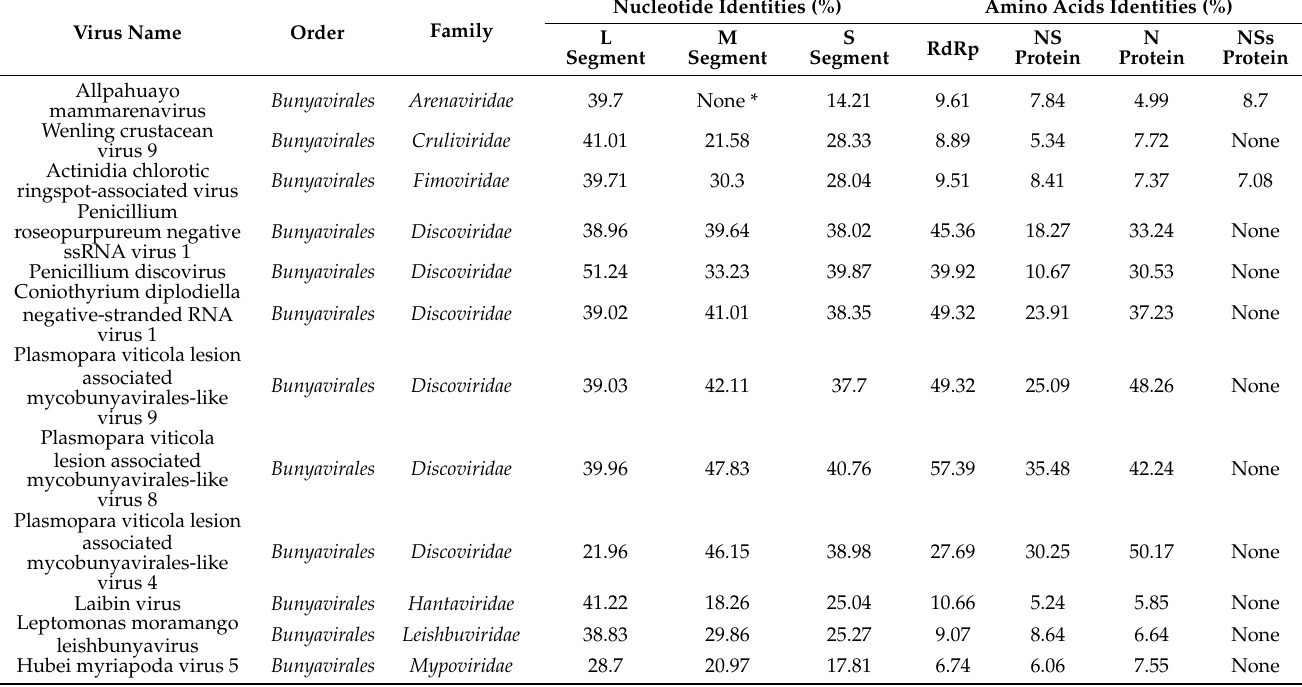
Figure 2. The genomic characteristics of RDaBV. ( A ) Schematic diagram of RDaBV genome organization. ( B ) Alignment of 3 (cid:48) and 5 (cid:48) ends of three genome strands of RDaBV. Table 1. The nucleotide and amino acid identities between RDaBV and the representative species in 14 families of the order Bunyavirales .